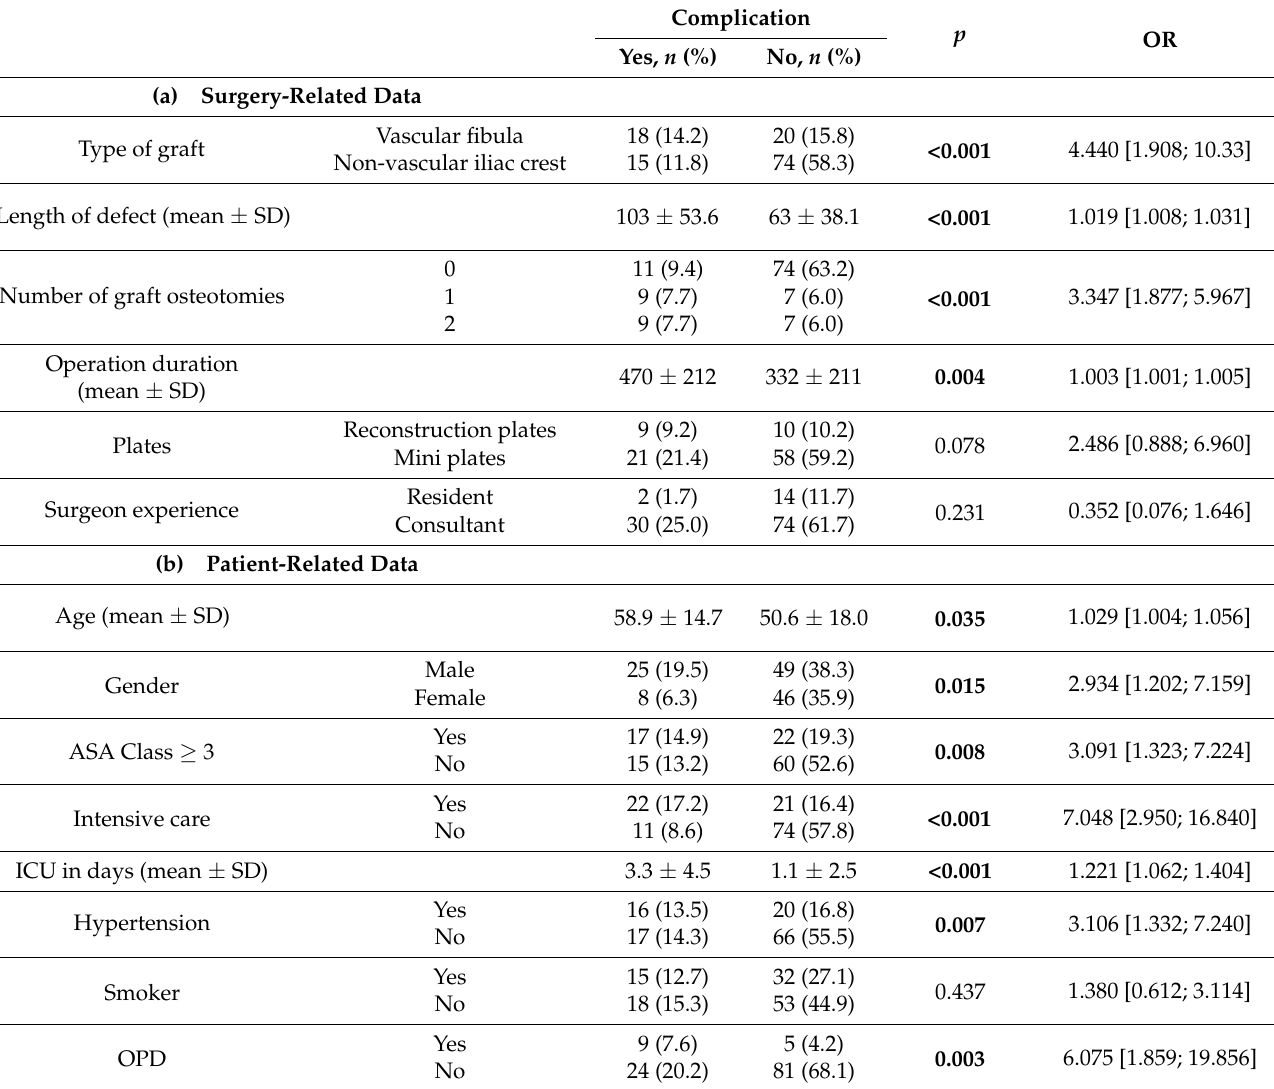
Table 5. Univariate Analysis of Risk Factors on